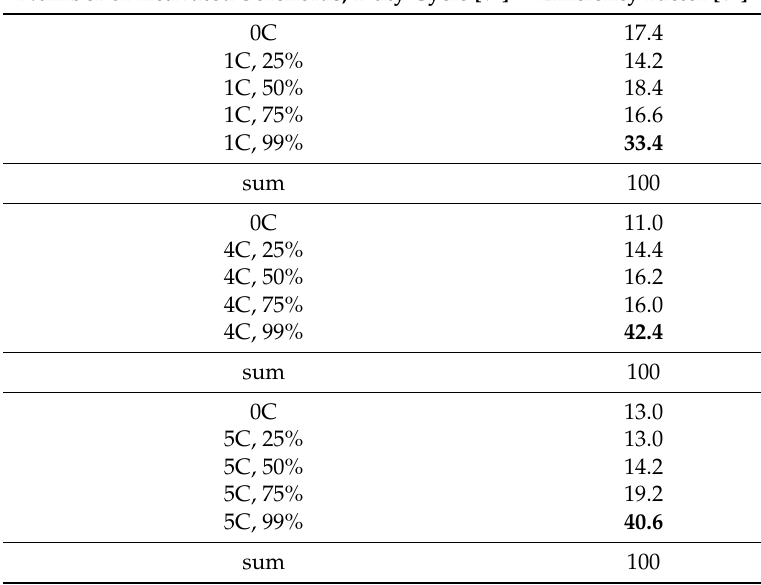
Table 4. Efficiency factors calculated for MFC2, depending on the number of solenoids and the value of duty cycle of a PWM